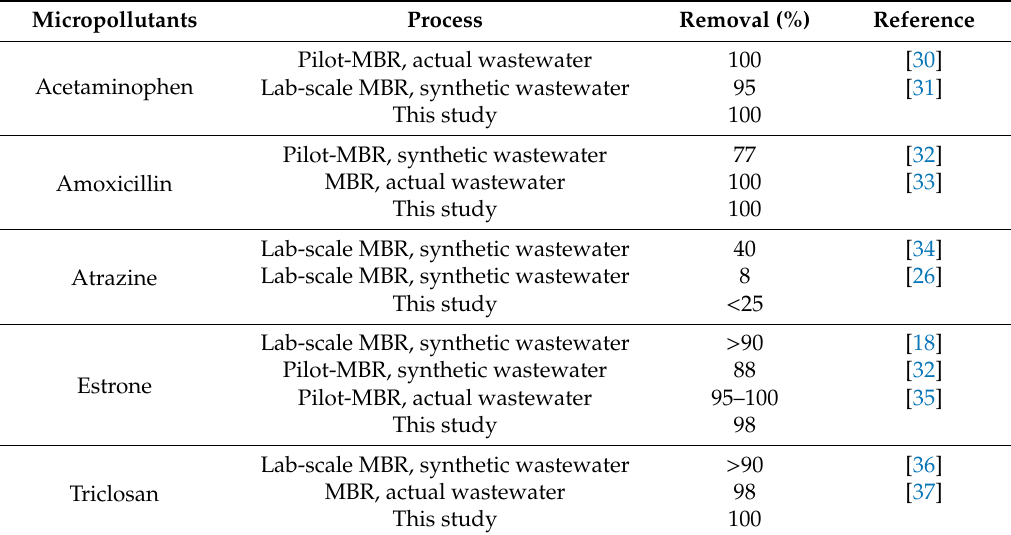
Table 4. Comparison of micropollutant removal obtained here with literature